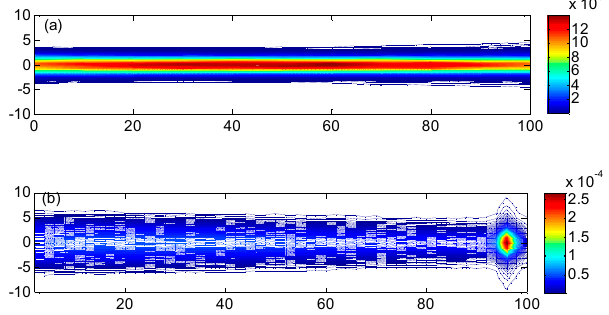
Figure 2. 2D ZEMAX simulation mapping: ( a ) Incident irradiant profile; ( b ) Power fraction profile of back-scattered light in different particle positions.